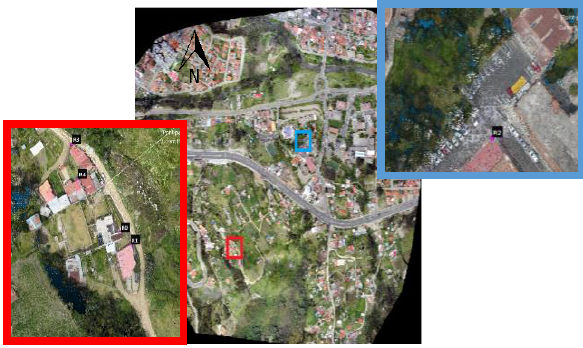
Figure 7. Map of the selected geo-referencing points. The alignment of these points produced a maximum error of 3.5 cm at the point A3 - R3, located in the southwest area, and a minimum of 5 mm in the central area. Considering itself acceptable since the accuracy of the UAV is 3 cm. Figure 8 depicts the geo-referencing errors associated with the Lidar-UAV